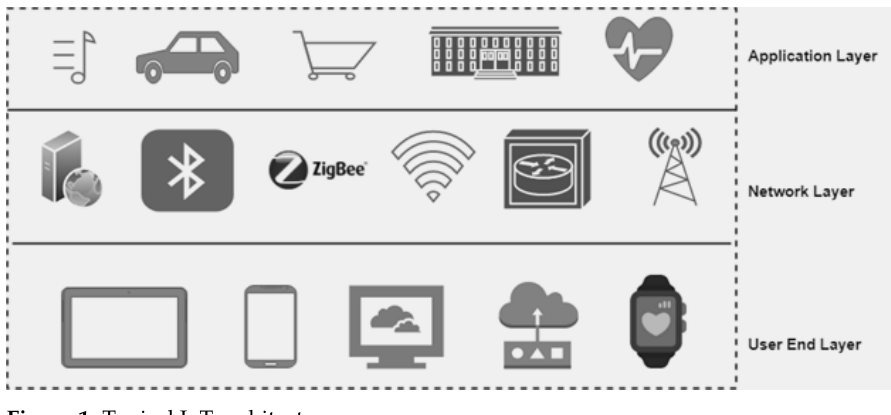
Figure 1. Typical IoT architecture.